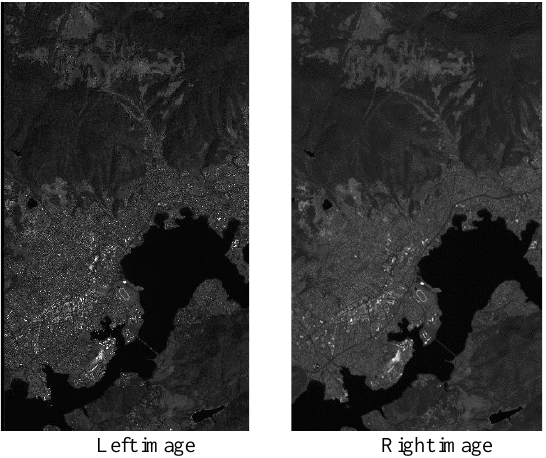
Figure 3. Overview of the GeoEye images dataset In the analysis part on the PT-based epipolarity model of this work, a number of evenly distributed points are selected from the left image; indeed, left images are divided into 10×10 blocks, the centre point of each image block is selected as the test point, 100 test points are selected totally. The point distribution on the whole image is about ten lines multiply ten columns. According